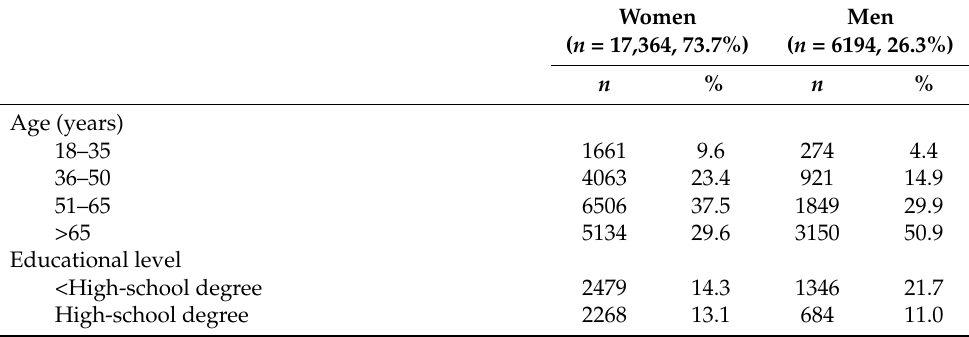
Table 1. Characteristics of the study population according to